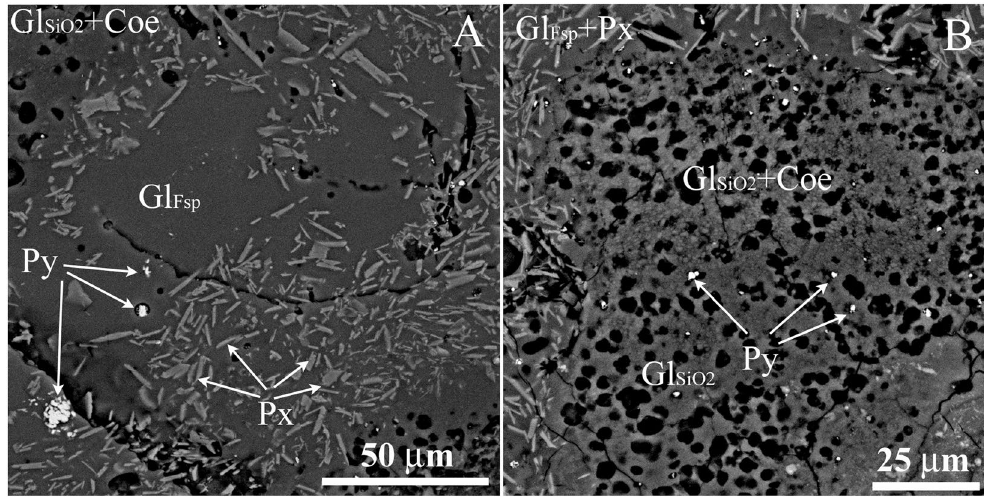
Figure 2. SEM images of different regions in UHPHT impact glass from a vein-like body in the Kara astrobleme, Kr-12–115, Kara river. ( A ) aluminosilicate glass with some pyroxene crystallites, ( B ) coesite- bearing silica glass drop within aluminosilicate glass surrounding matter. Black rounded regions in ( B ) are pores, produced probably at vacuum probe preparing by recovering of liquid (water-rich) inclusions in glass. Gl Fsp and Gl SiO2 – feldspar and quartz melting glasses, Coe – coesite, Px – pyroxene, Py –